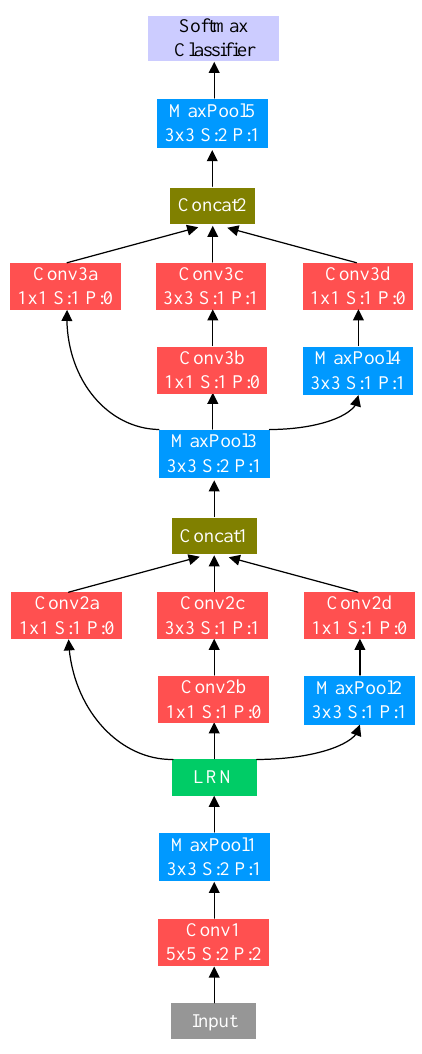
Figure 2. Proposed NIRFaceNet (LRN: local response normalization).